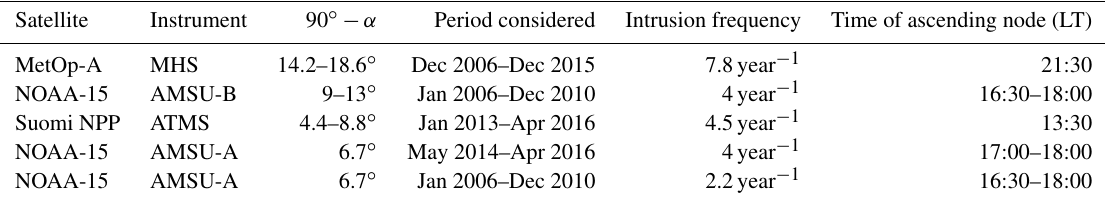
Figure 1. Viewing direction of the deep-space view (DSV, short dashed line) compared to the celestial equator and the ecliptic plane (long dashed line). For simplicity, the slight tilt of the Moon’s orbit against the ecliptic is not displayed. The DSV direction has a typical angle α ≈ 75 ◦ against nadir and describes a circle in the sky during one orbit. Table 1. Frequency of appearances of the Moon in the deep-space view for different instruments. The third column gives the angle(s) between the orbital axis of the artificial satellite and the DSV position(s). Intrusions affect several orbits in a row (see Table 2); the fifth column gives their